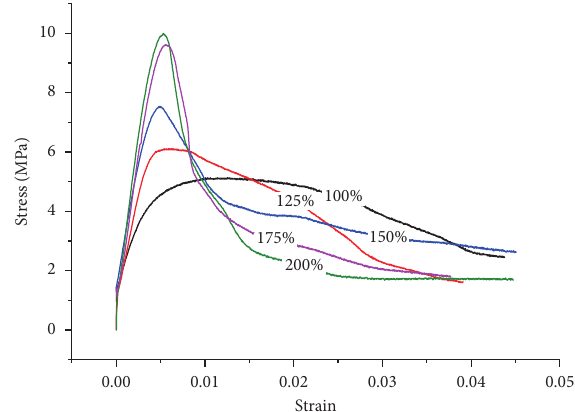
Figure 6: Stress-strain curves of 3D-printed samples during UCS tests under different core saturation levels.